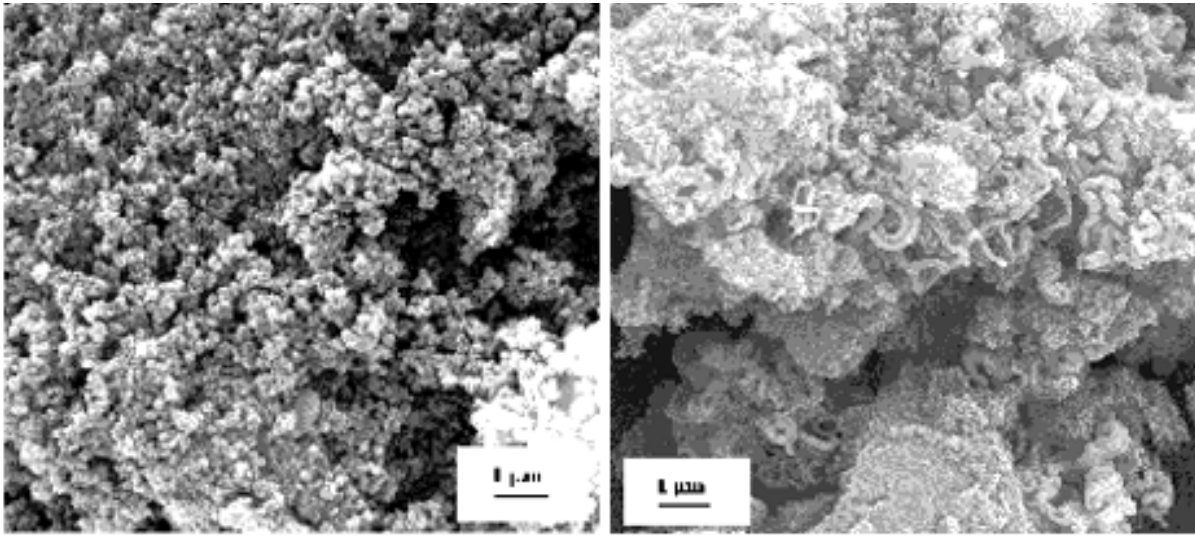
Figure 9. SEM micrographs of the SiMCM-41 samples. (a) Si MCM-41 (p/48), (b) Si MCM-41